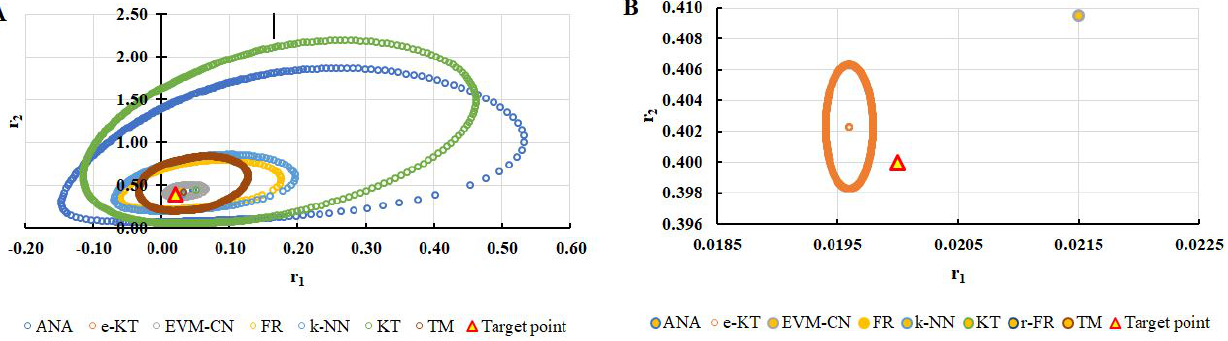
Figure 13. The JCR of analyzed methods for reactivity ratios calculation for MC1 imposed condition ( A ) and detail of smallest JCR with distribution of reactivity ratios ( B ).